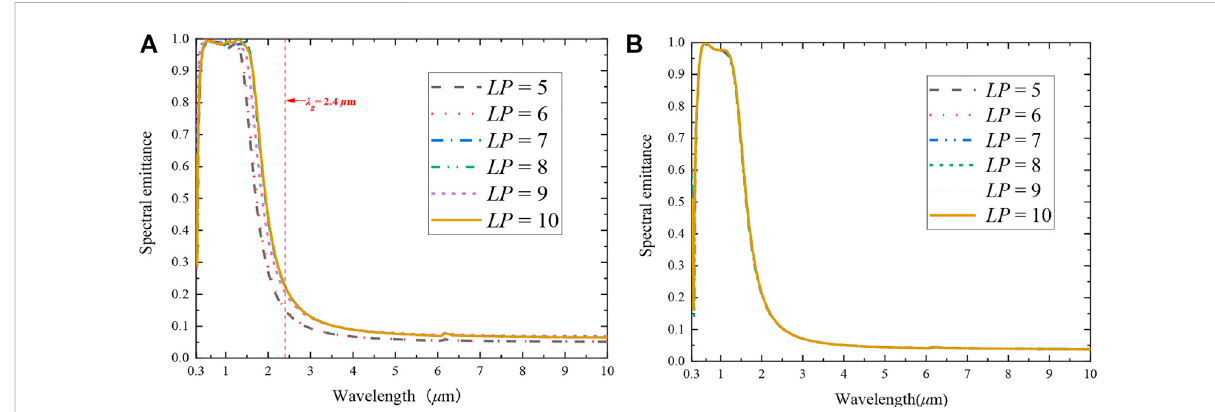
FIGURE 7 (A) Variationofstructuralspectralemittancewiththenumberoflayerpairsfor fi xedotherparameters( r =60 nm, a =200 nm, d M =10 nm, d D = 80 nm, n